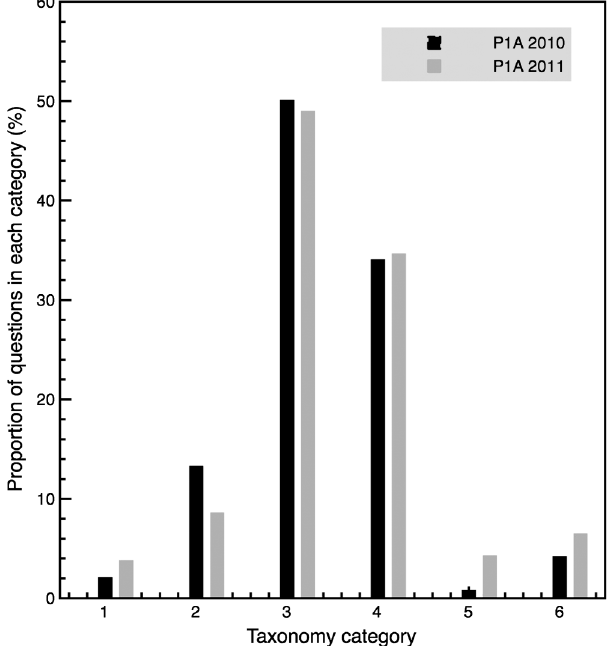
FIG. 2. Proportion of questions in each taxonomic category, for Physics 1B question repositories for 2010 ( N ¼ 179 , dark bars) and 2011 ( N ¼ 73 , light